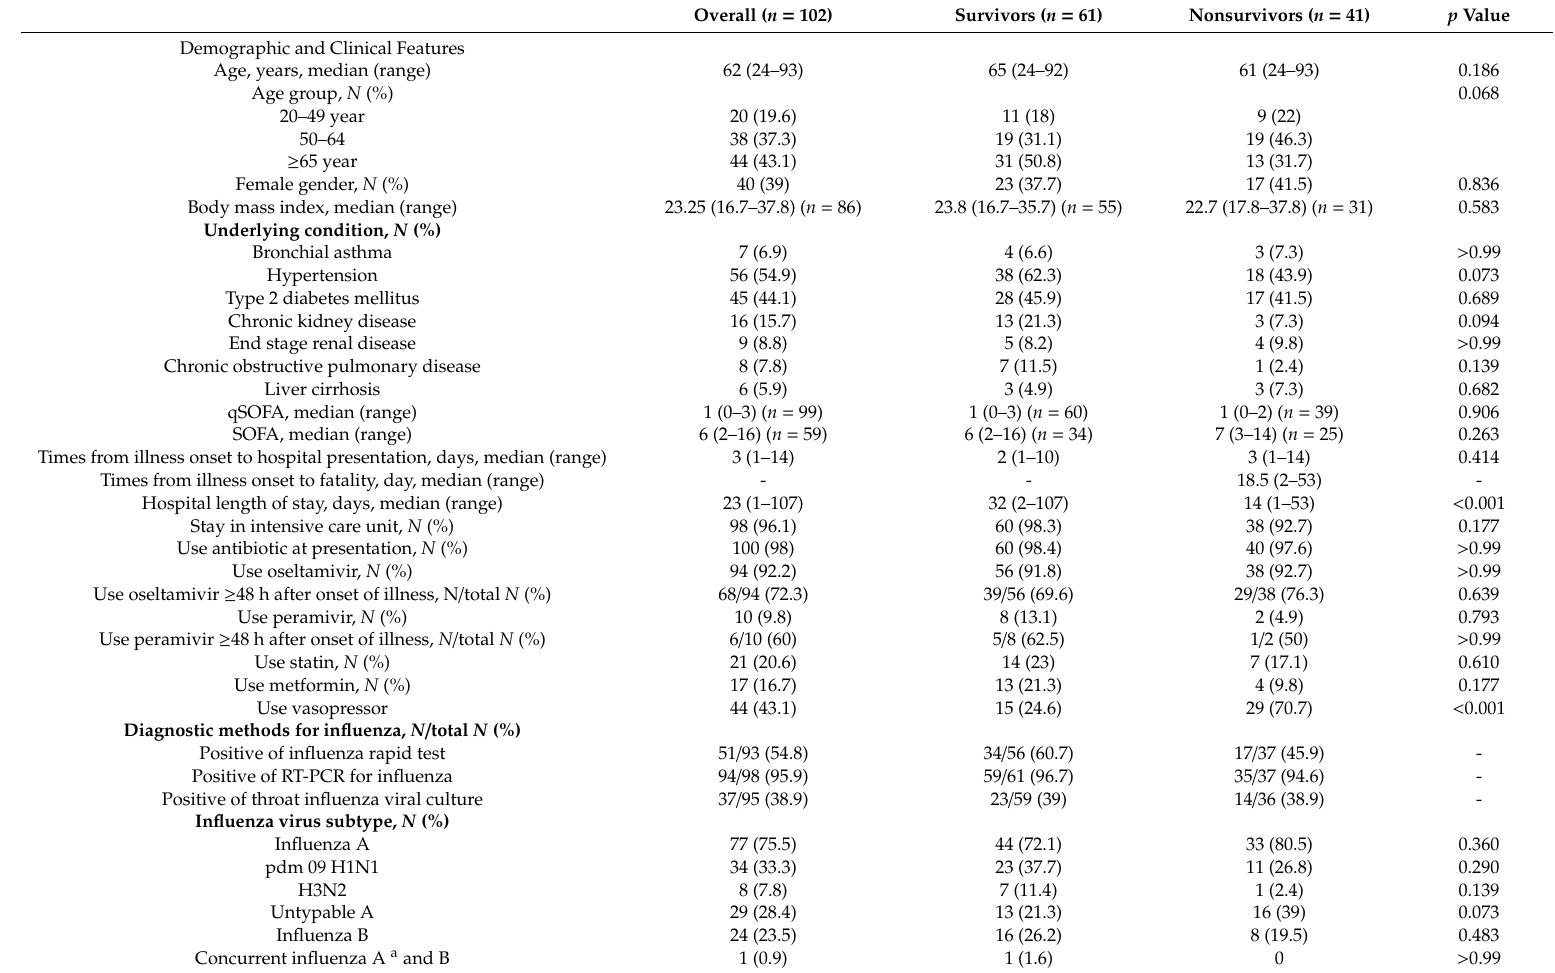
Table 1. Characteristics and diagnostic methods of patients with severe